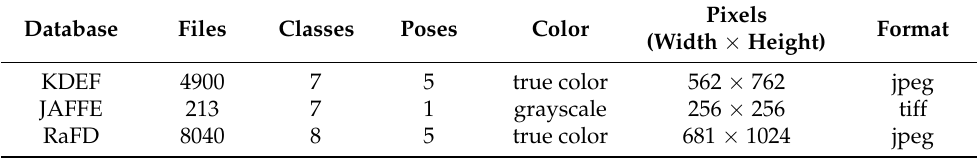
Table 1. Databases number of files, classes, poses, colors, dimensions of images, and